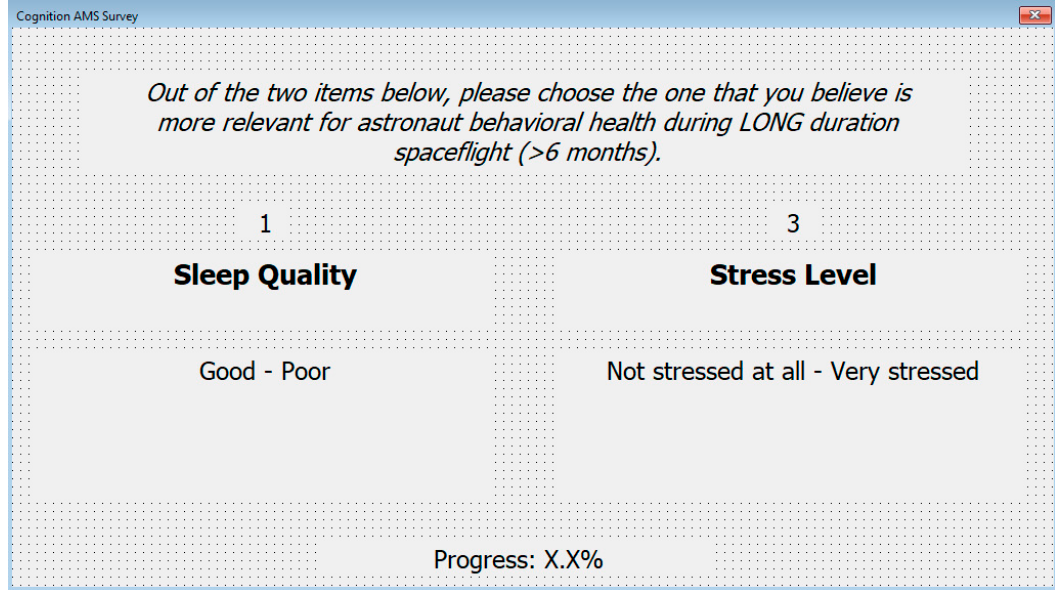
Figure A2. Example screenshot of one of the 91 comparisons each subject matter expert had to perform.